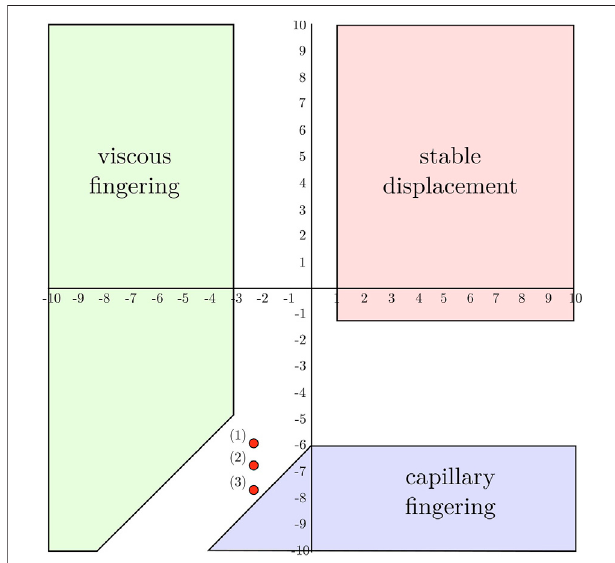
FIGURE 1 | Phase diagram on a log(M)-log(Ca) scale and limits of the three fl uid fl owregimes.Thethreeexperiments atalog(Ca)of − 5.90(1), − 6.67 (2) and − 7.67 (3) are identi fi ed